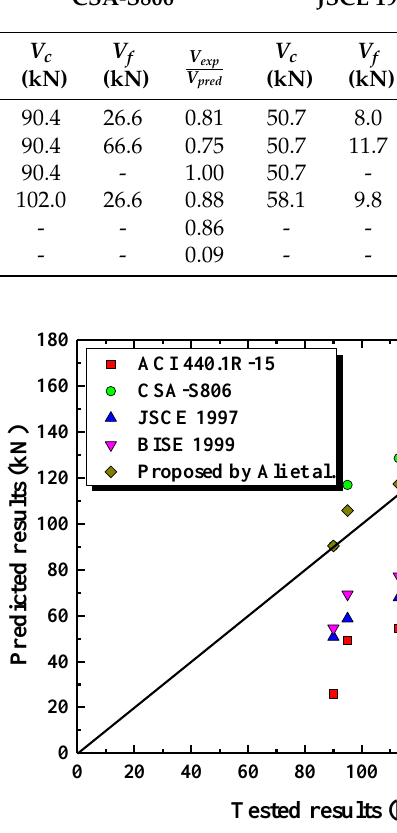
Figure 24. Comparison of predicted and tested shear capacities.